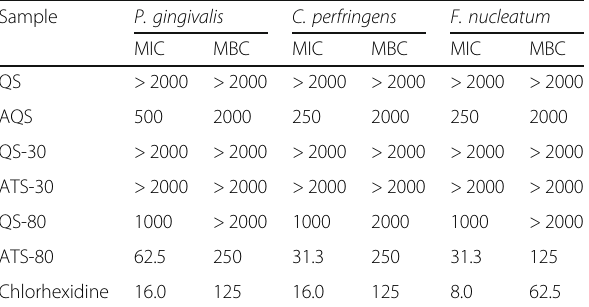
Table 1 MIC and MBC values of saponin fractions against the three halitosis bacteria ( μ g/mL)